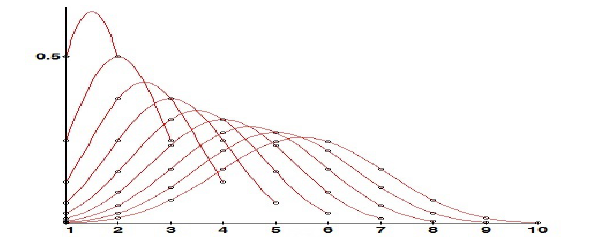
for all n = 1, . . . ,9 and i = 0, . . . , n − 1. i